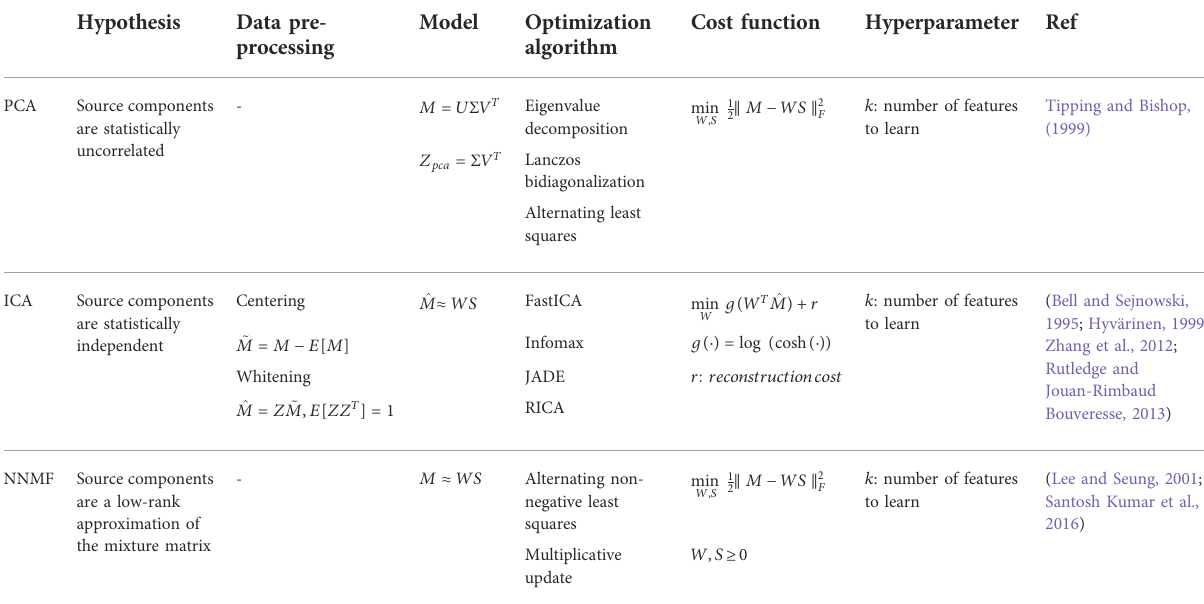
TABLE 1 BSS algorithms ’ technical speci fi cations.